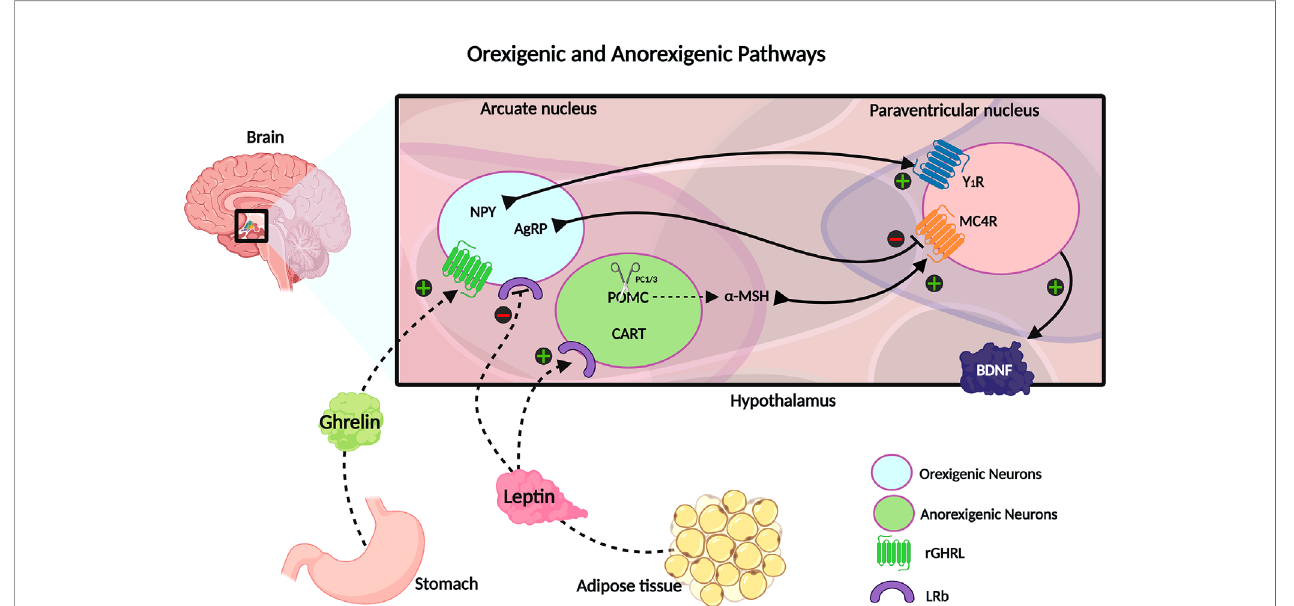
FIGURE 1 | The neuroendocrine circuit regulated by leptin and ghrelin hormones. Ghrelin is secreted by the stomach in response to a decrease of energy stock and upregulates the orexigenic neurons, stimulating the NPY and AgRP signaling, which promotes the increase of energy intake and decreases the energy expenditure. On the opposite, there is the leptin hormone, mainly secreted by fat tissue, and acts in inhibiting orexigenic neurons and upregulating anorexigenic neurons to express CART and POMC; the last one is cleaved into a -MSH. CART and a -MSH potentialize the satiety signal and increase the metabolic rate. Created with